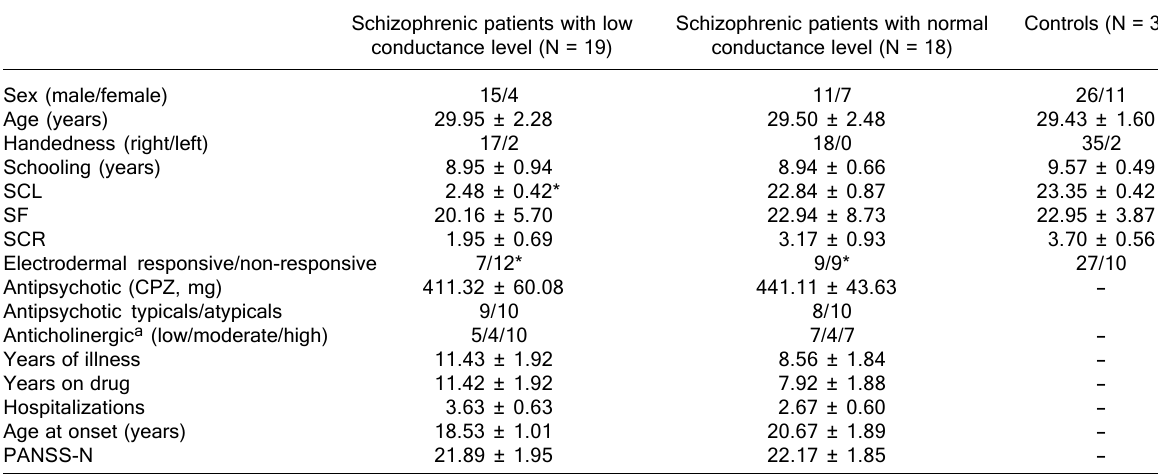
SCL = skin conductance levels; SF = skin conductance spontaneous fluctuation; SCR = skin conductance orienting response; CPZ = chlorpromazine equivalents (30); PANSS-N = negative subscale of the Positive and Negative Syndrome Scale. a Patients catego- rized, blindly and independently, by two psychiatrists according to the anticholinergic effects of medications used. *P < 0.05 compared to control (Duncan and chi-square